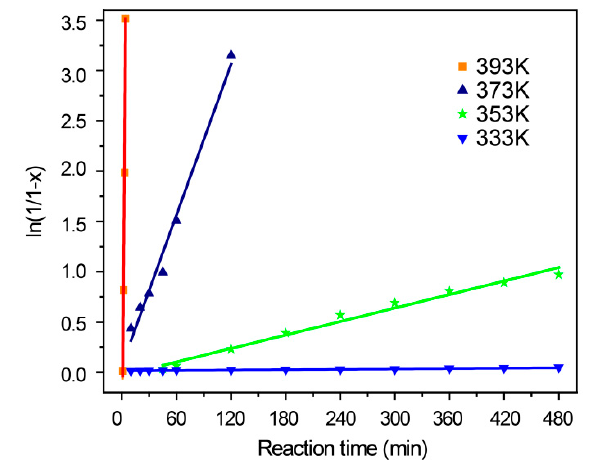
Figure 11. ln (1 / 1 − x) versus reaction time in di ff erent Figure 11. ln (1/1 − x) versus reaction time in di ff erent temperature. Figure 11. ln (1/1 − x) versus reaction time in di ff erent temperature.